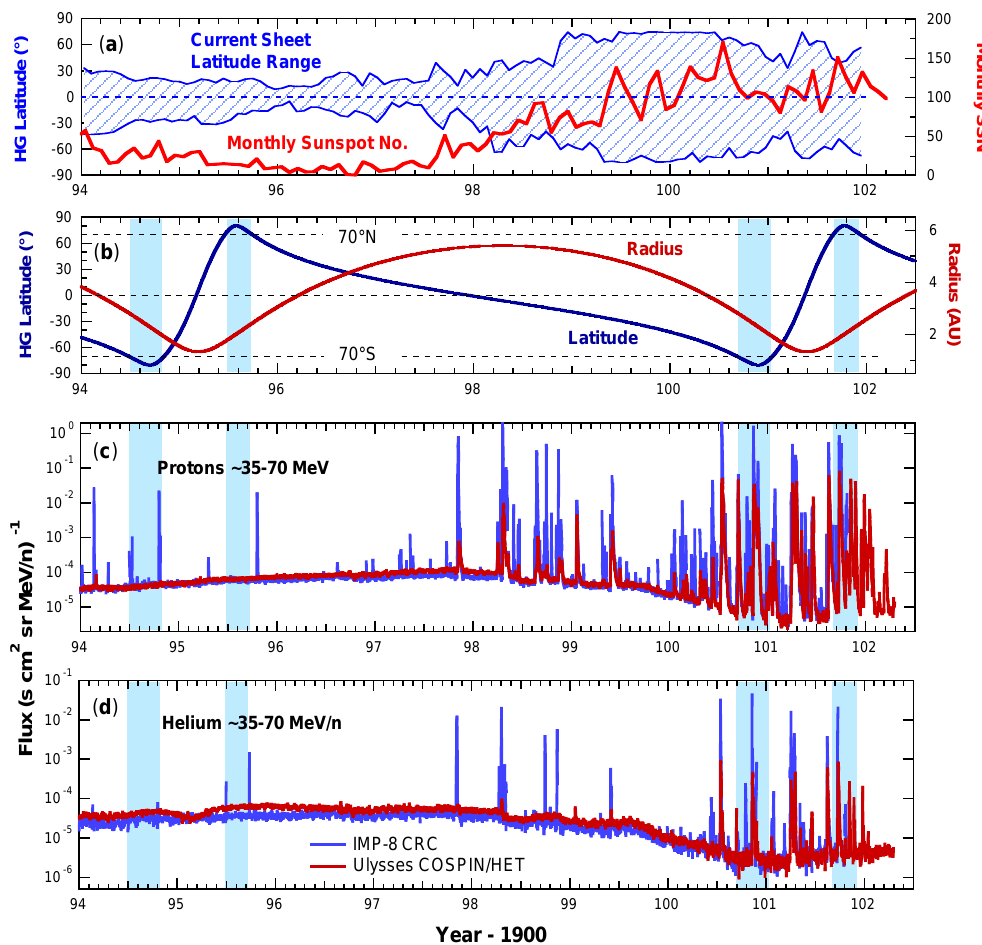
Fig. 1. (a) Proxies for the level of solar activity: Blue shading, left axis, maximum latitudinal extent of the current sheet dividing opposite magnetic polarities in the corona (Wilcox Solar Observatory). Red curve, right axis, monthly sunspot number (SIDC, RWC Belgium, World Data Center for the Sunspot Index, Royal Observatory of Belgium and Solar Geophysical Data reports). (b) Ulysses trajectory. Heliocentric Radius (red curve, right axis); Heliographic latitude (blue curve, left axis. Polar passes are defined by Ulysses latitude > 70 ◦ . (c) Fluxes of energetic protons observed by Ulysses (red curve) and IMP-8 near Earth (blue curve). Energy ranges are ∼ 39–70MeV for Ulysses, and ∼ 30– 70MeV for IMP, represented, for brevity in discussion, as ∼ 35–70MeV. In all figures in this paper near-Earth observations are represented by blue curves and Ulysses observations are represented by red curves. No IMP-8 observations are available after suspension of IMP-8 operations on day 299 of 2001. (d) Fluxes of energetic Helium nuclei at Ulysses and IMP-8. Actual energy ranges are ∼ 39–70MeV/n for Ulysses, and ∼ 30–70MeV/n for IMP, represented, for brevity in discussion, as ∼ 35–70MeV/n. Near solar minimum (1995–96) the anomalous component dominates the helium fluxes. Near solar maximum (2000–01) the quiet-time Helium flux consists mainly of galactic cosmic